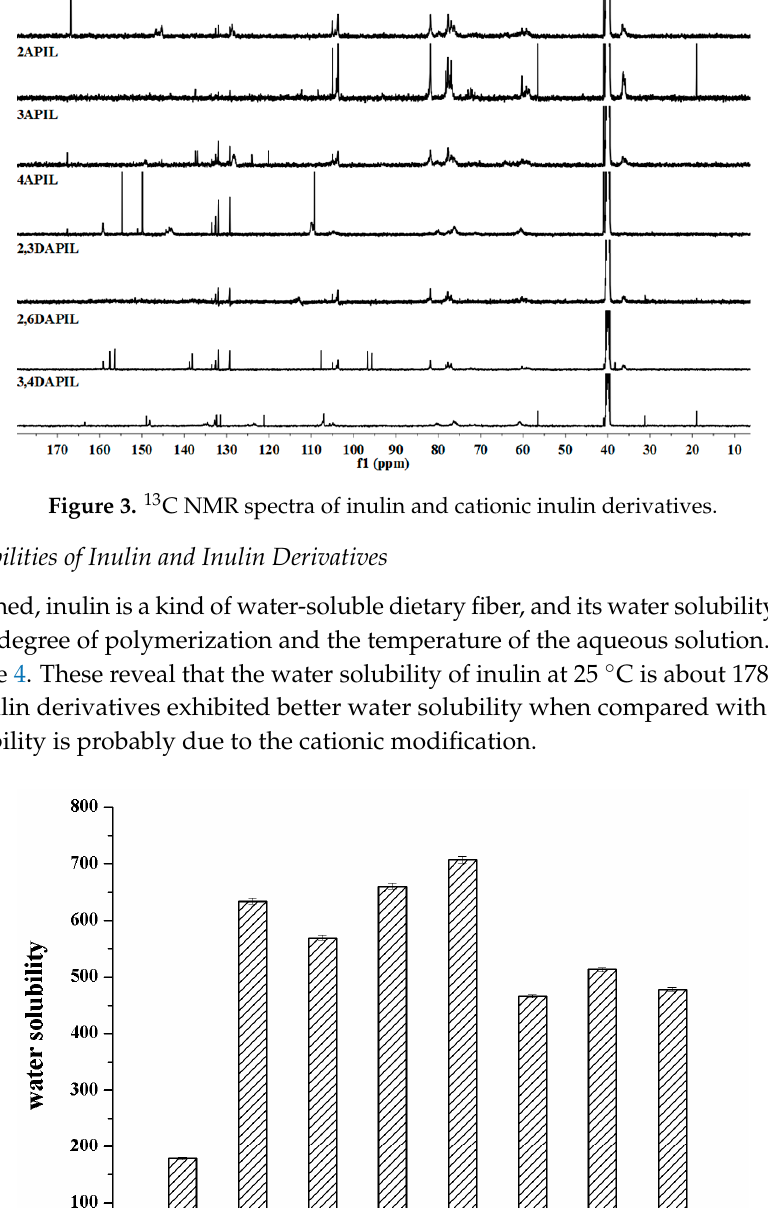
Figure 3. 13 C NMR spectra of inulin and cationic inulin derivatives.